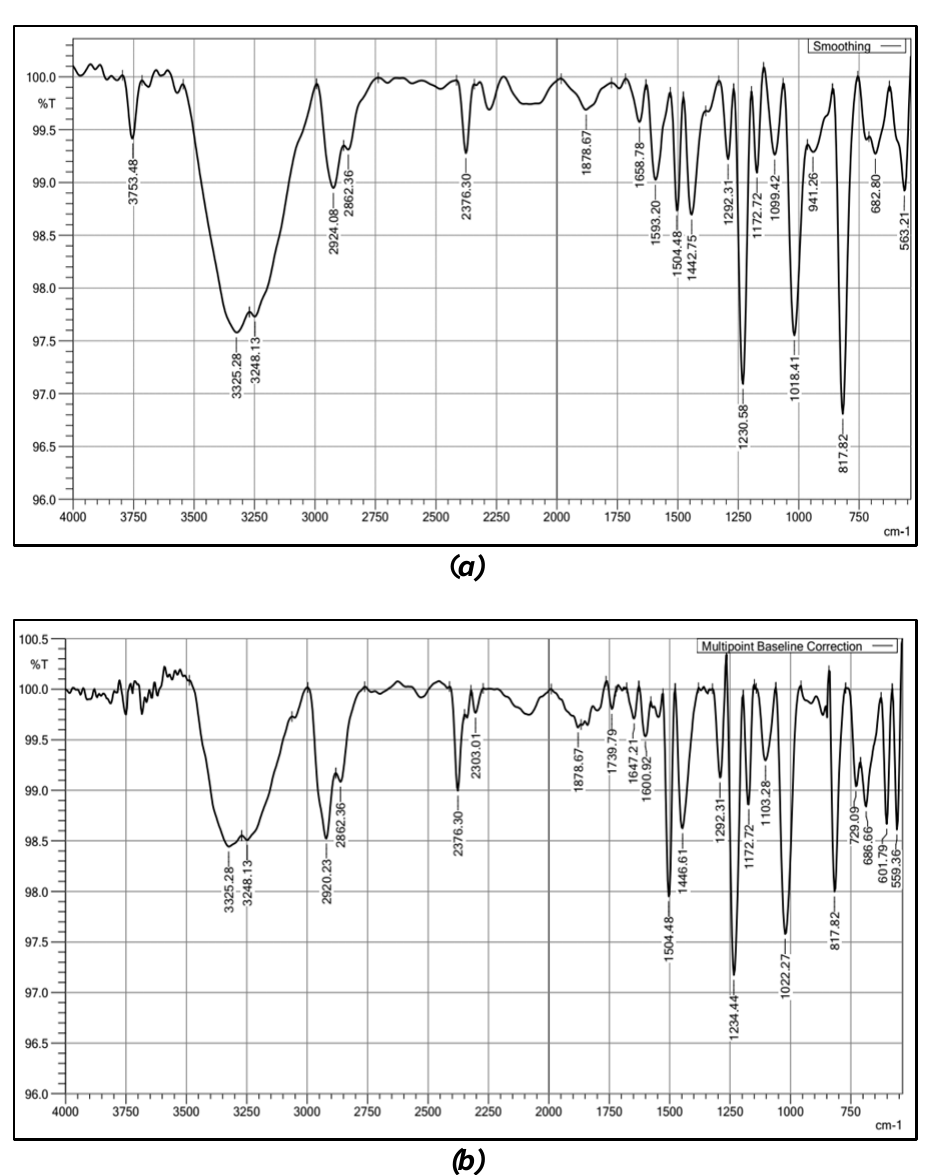
Figure. 2: FTIR images of: a. epoxy b. ZnO/epoxy nanocomposite with 2wt.%content of ZnO.